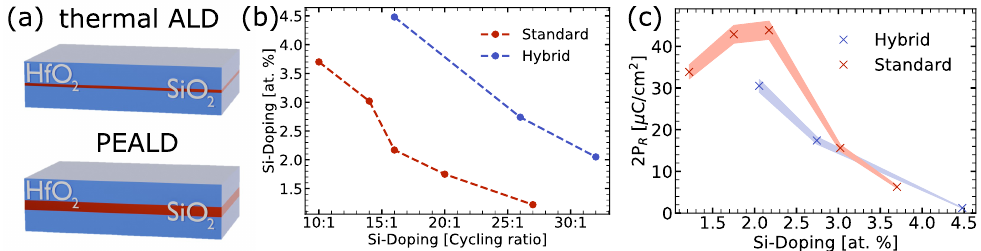
Figure 6. Schematic illustration of a partial HSO ALD stack with one SiO 2 ALD-monolayer after de- position ( a ). The observed thickness difference is responsible for a shift in Si-concentration compared to cycling ratios ( b ). P R values versus Si concentrations from a consistent trend for both deposition processes ( c